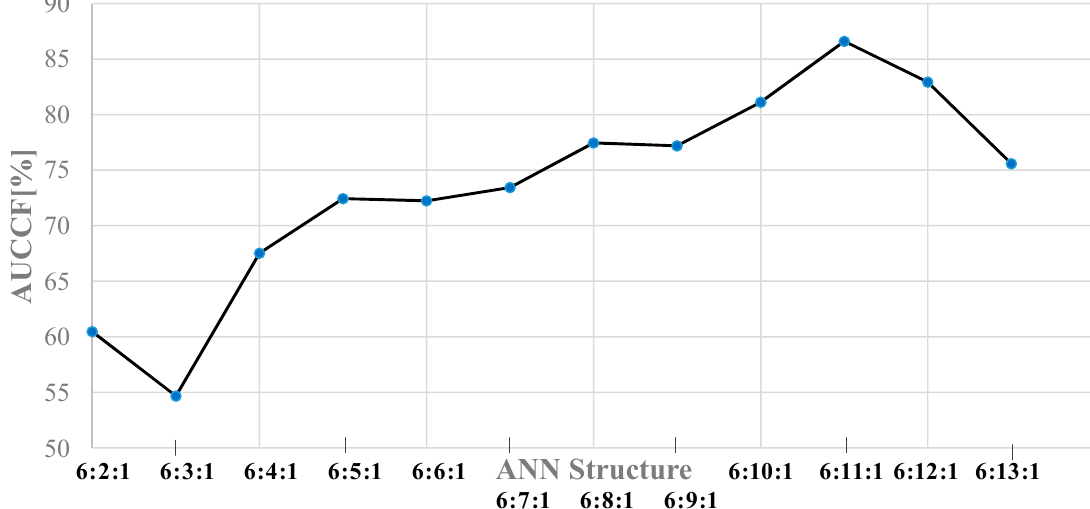
Figure 9. Area under the correct classification factor (AUCCF) curve of the neural network with different structures.